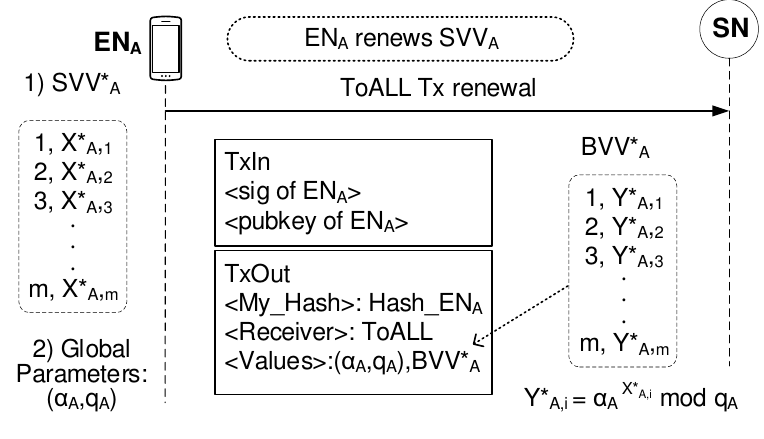
Figure 10. ToAll Tx